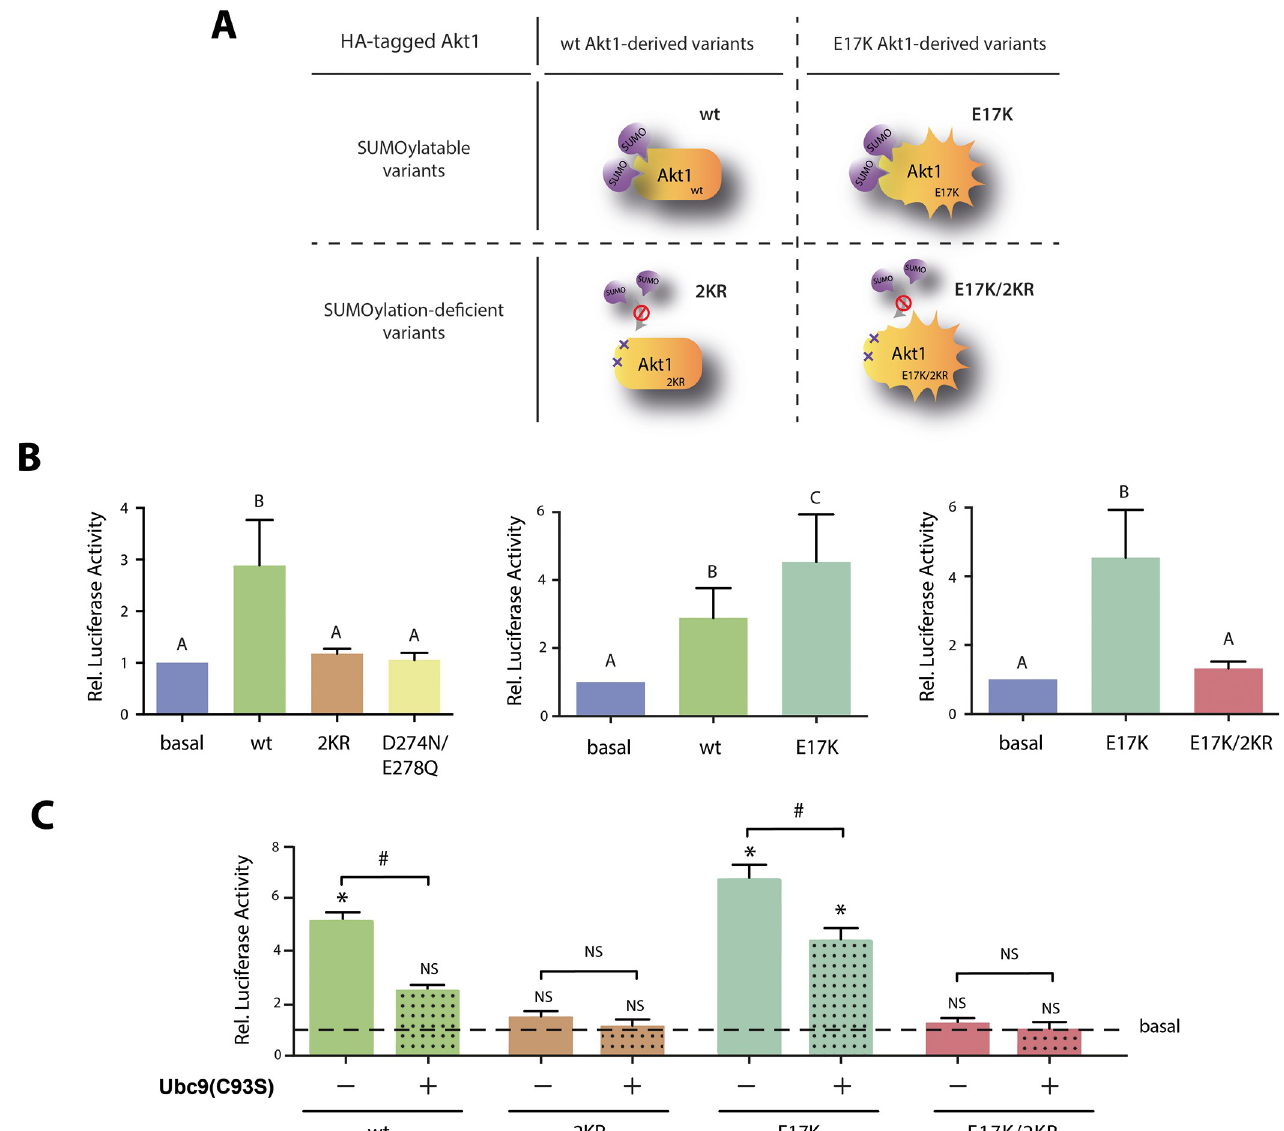
Fig 1. SUMO conjugation of Akt impacts on Nanog promoter activity in ES cells. (A) Cartoon representing the main features of the Akt variants most used in this work. SUMO group is represented by violet balloons, hyperactivity-inducing E17K mutation is depicted with thorny edges and mutated lysines in 2KR and E17K/2KR variants are indicated by the Xs. (B) ES cells were transfected with Nanog5P reporter along with an expression vector encoding for either wt Akt1, the Akt1 mutants 2KR, D274N/E278Q, E17K, E17K/2KR or the empty vector (basal). Luciferase activity was measured in extracts obtained from transfected cells maintained in standard medium in the presence of LIF and 2i for 72 h. Results were referred to the control condition (basal) and are shown as mean ± SEM of three independent experiments. Statistical analysis was performed by linear mixed models (LMM) with a randomized block design (RBD). Significant differences were assessed using the DGC test. Different letters indicate significant differences among cellular conditions (p < 0.05). (C) ES cells were transfected with Nanog5P reporter along with the wt, 2KR, E17K and E17K/2KR Akt1 variants or the empty vector (basal, solid bars) and also including (+) or not (-) a vector encoding the dominant negative Ubc9(C93S) (dot-patterned bars), as indicated. Results were referred to the corresponding control condition (basal, indicated as a dashed line) and are shown as fold change mean ± SEM of three independent experiments. Statistical analysis among groups was performed by lineal mixed models (LMM) with a randomized block design (RBD) and comparisons were performed using the Tukey’s HSD test. Fold change comparisons between groups were assessed by two-tailed paired t test. Asterisks indicate significant differences and NS above bars denote no significant differences of each condition compared to the basal (p < 0.05). Hashes indicate significant differences between fold change of the same Akt1 variant with (+) or without (-) Ubc9(C93S) (p < 0.05).